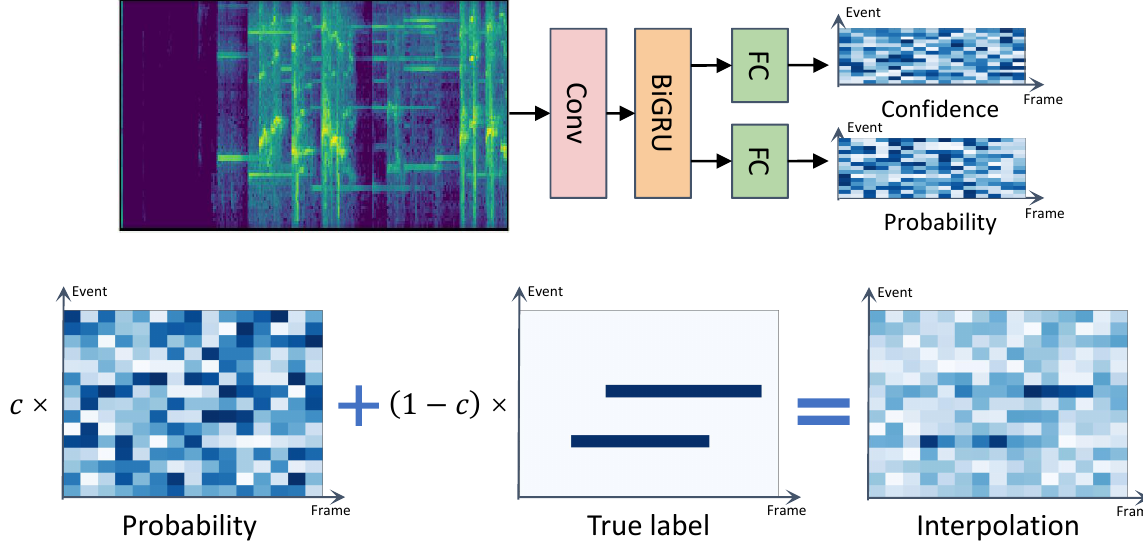
Figure 1. The top of the figure shows that a sound event system with an extra confidence branch. The sound event model receives the input spectrogram and outputs frame-level prediction probabilities and the corresponding frame-level confidence values. The bottom of the figure illustrates the process of the generation of new probabilities with output probabilities, targets, and confidence